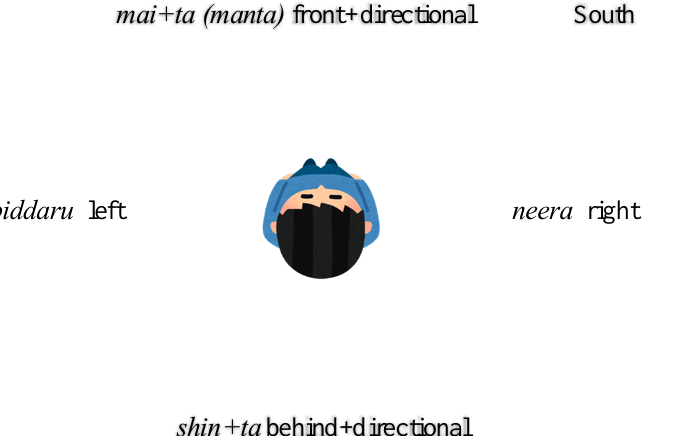
shin+ta behind+directional Figure 4. House system inside the home (Sik¯aza). Very close at hand (sitting or standing Figure 4. House system inside the home (Sikāza). Very close at hand (sitting or standing inside). mai+te (mante) front+hand South